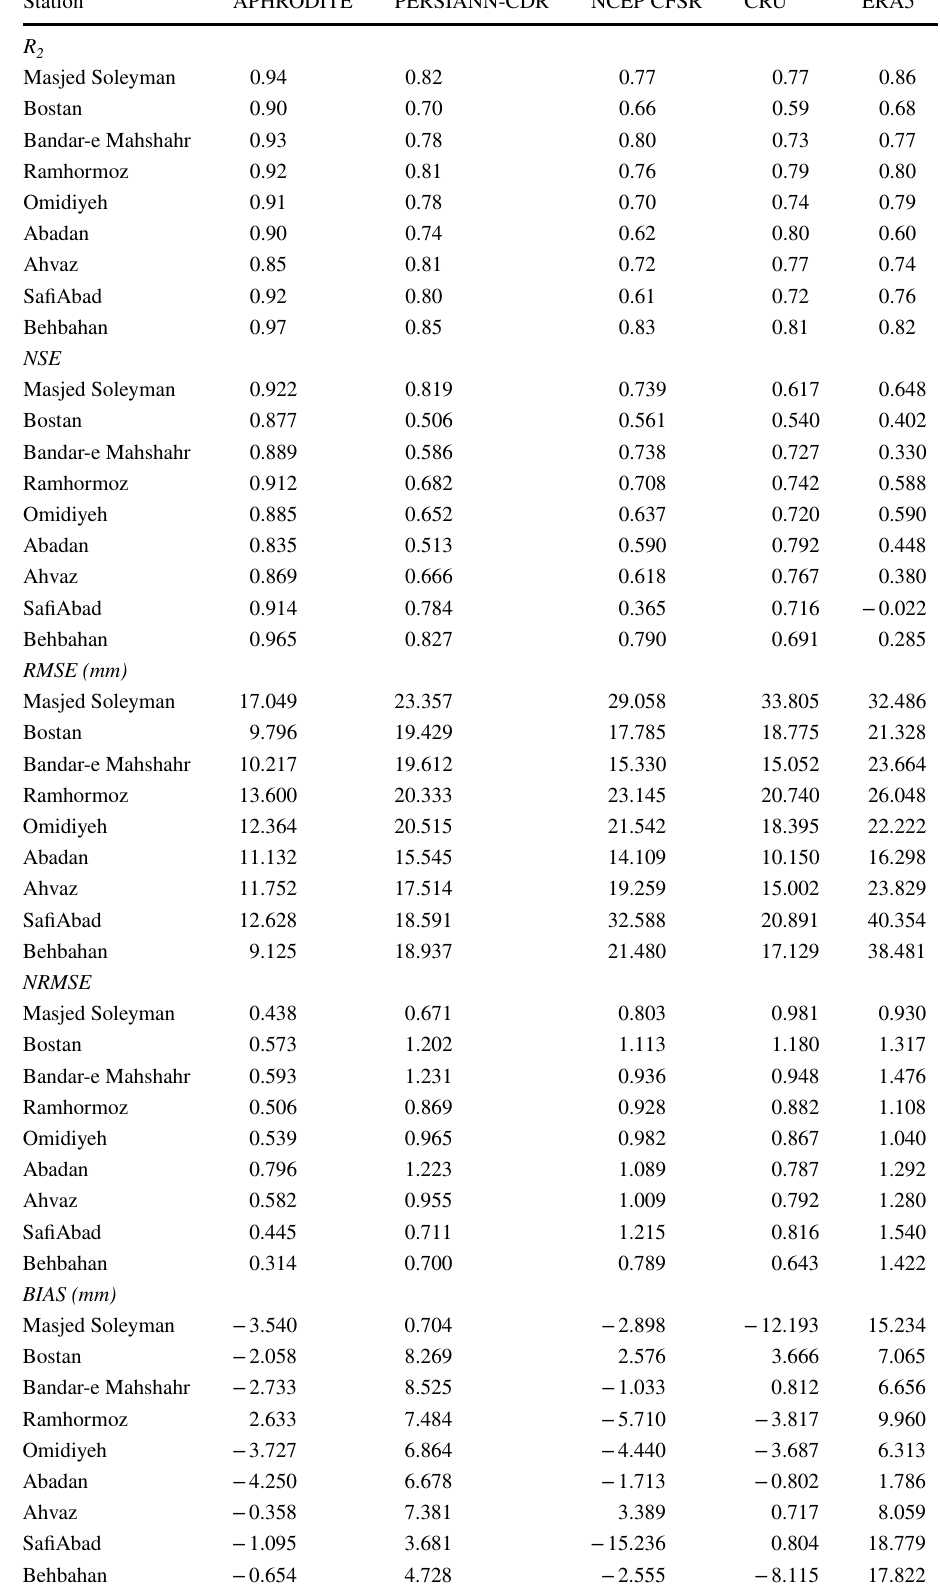
Table 6 The performance criteria for different synoptic stations and PCP